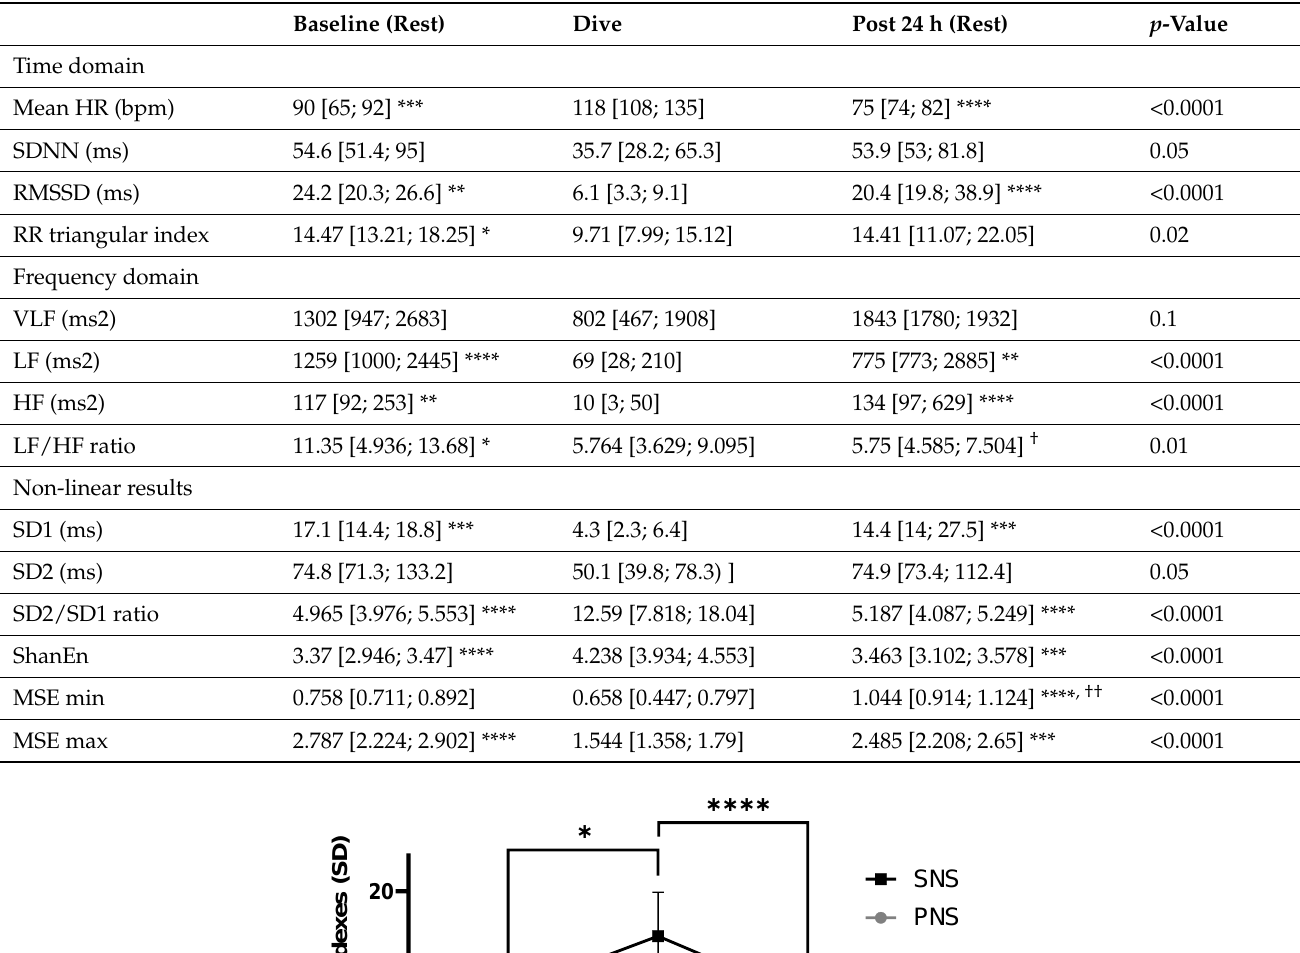
Table 4. HRV parameters. Data were recorded at rest, in sitting position at baseline and 24 h after last day dive. Dive measurements were recorded in immersion during the diving program ( n = 23). HR, heart rate; SDNN, standard deviation of normal-to-normal R waves; RMSSD, root mean square of the successive difference; RR triangular index, R–R intervals, and integral of the density of the R–R interval histogram divided by the maximum of its weight; VLF, very low-frequency; LF, low frequency; HF, high frequency; SD1, beat-to-beat HR variability; SD2, global HR variability; ShanEn, Shannon entropy; MSE, multi-scale entropy. p -value for the Friedman test. Dunn’s multiple comparisons test is expressed versus dive with * p < 0.05, ** p < 0.01, *** p < 0.001 and **** p < 0.0001. Differences versus baseline are expressed with † p < 0.05 and †† p < 0.01.